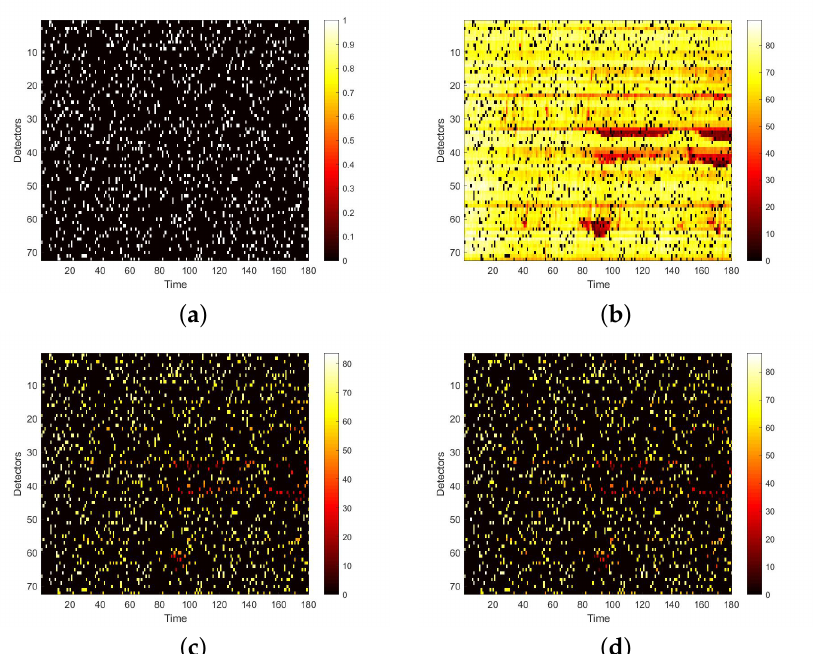
Figure 14. Speed matrices of Neihuan elevated highway (the 36th day of testset) with discrete damage visualized as heat maps. The ratio of damaged area to total area is 10%. ( a ) Mask matrix visualized as a heat map. ( b ) Damaged speed matrix visualized as a heat map. ( c ) Repaired speed matrix visualized as a heat map. ( d ) Real speed matrix visualized as a heat